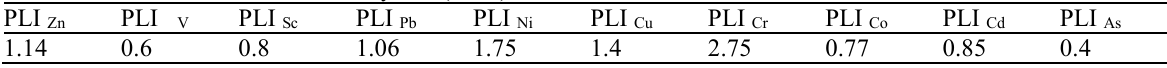
Table 7. Pollution bar index of refinery soil (P.L.I)